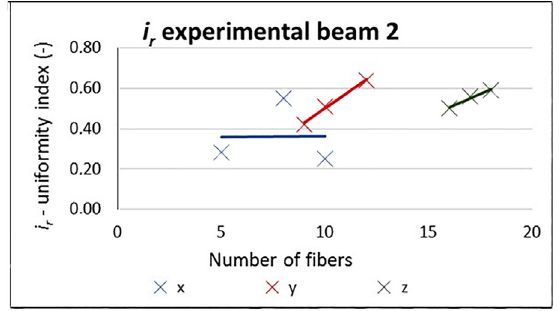
Figure 12. Output chart with i r core